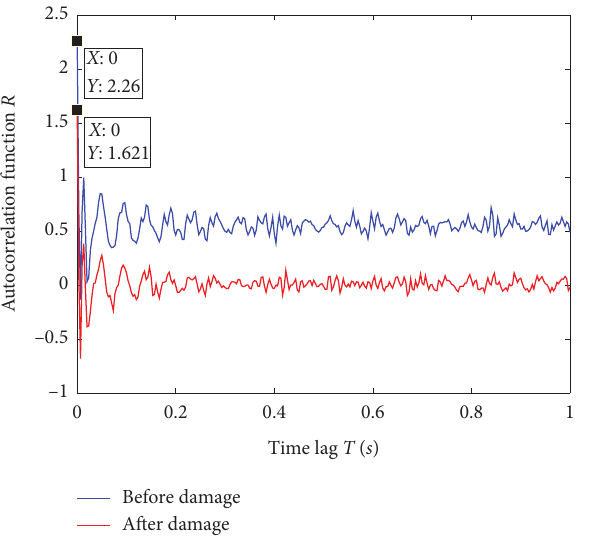
Figure 8: Autocorrelation function at P1.